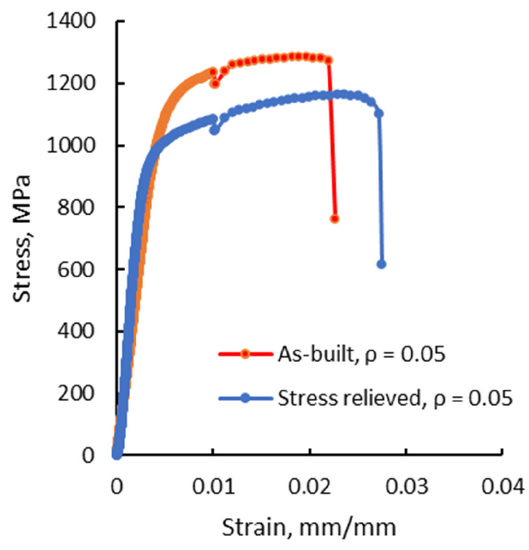
Figure 10. Stress-strain curves for V-notched test pieces with 0.05 mm notch root radius in as-built and stress-relieved states.